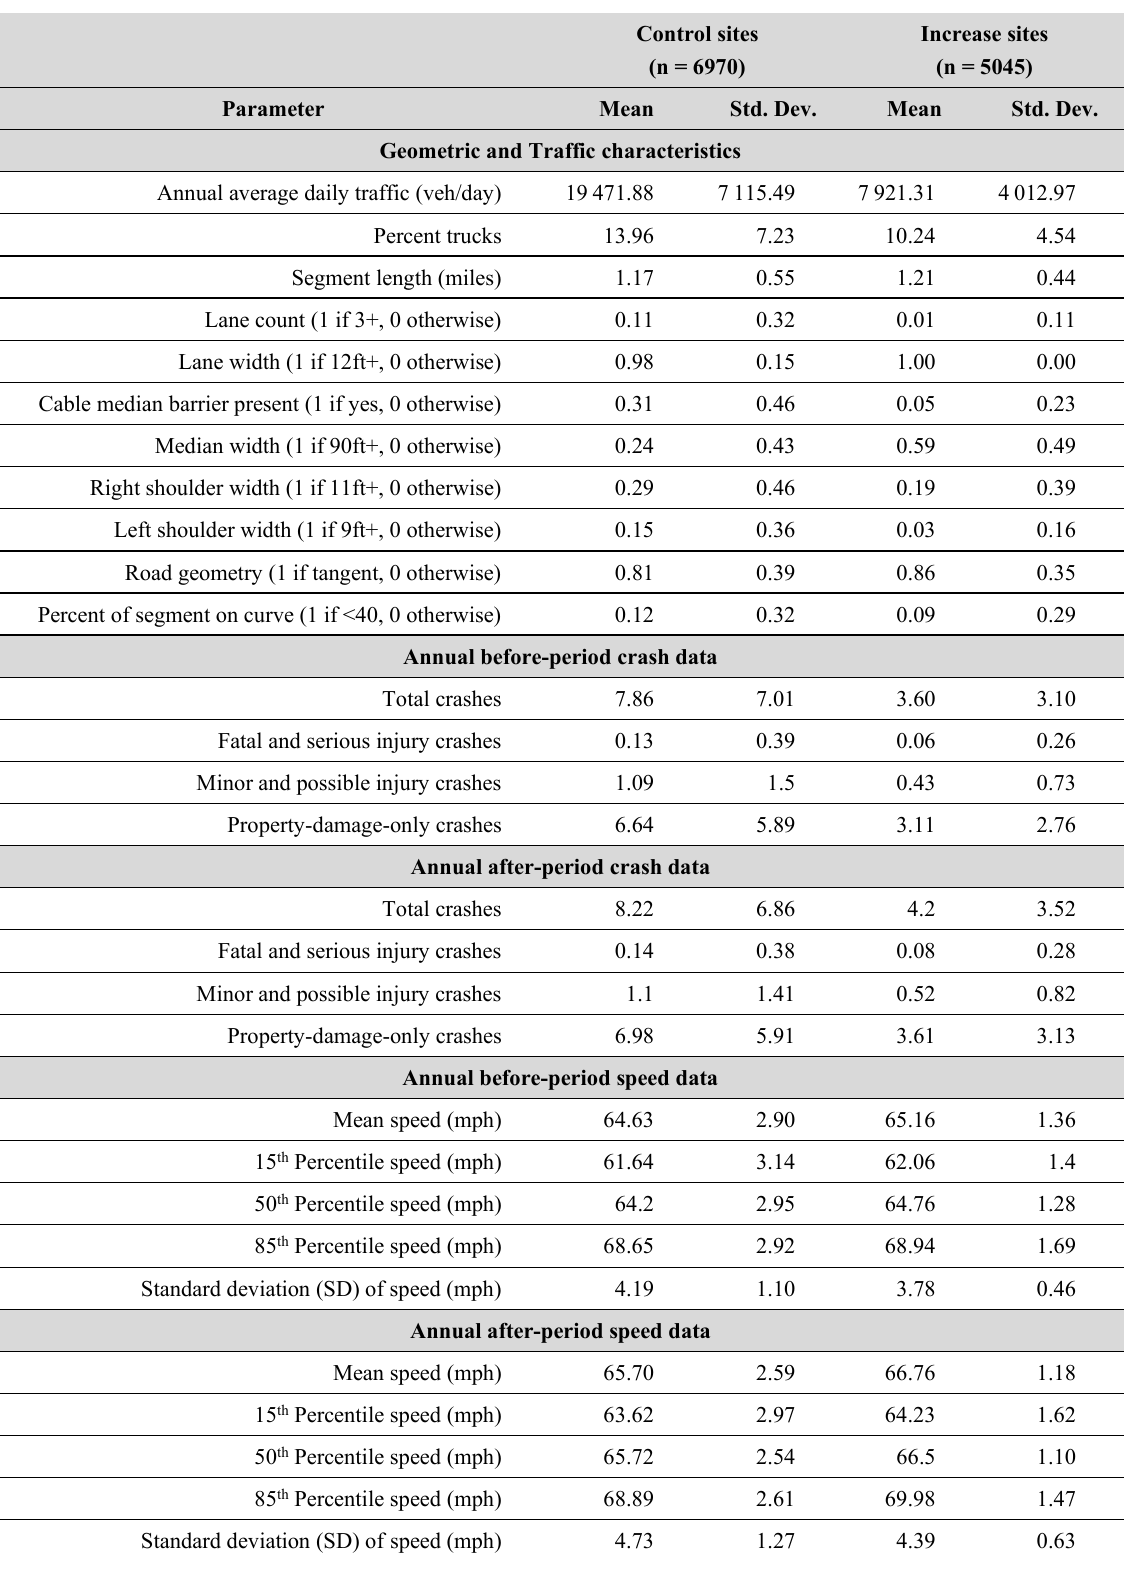
Table 1 Descriptive statistics of pertinent